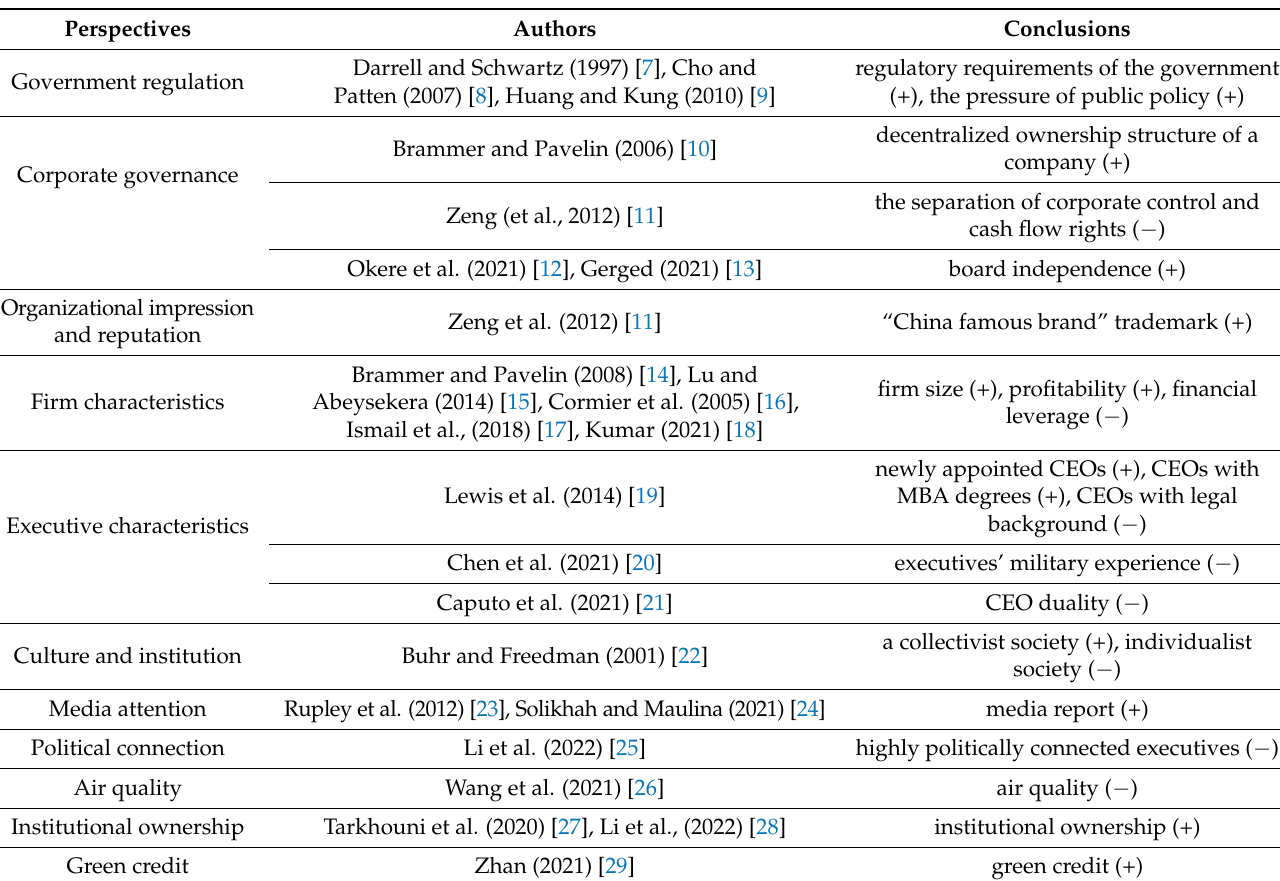
Table 2. Summary of main research conclusions on influencing factors of environmental information disclosure